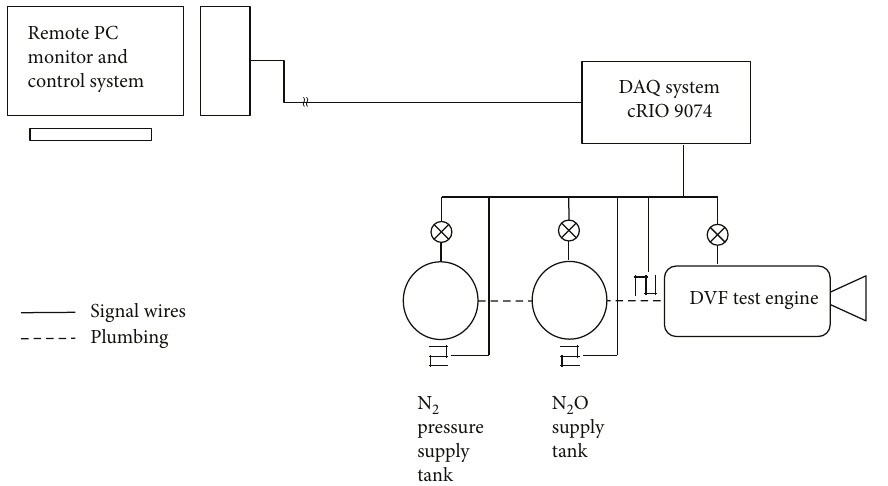
Figure 6: Schematic diagram of the EGSE